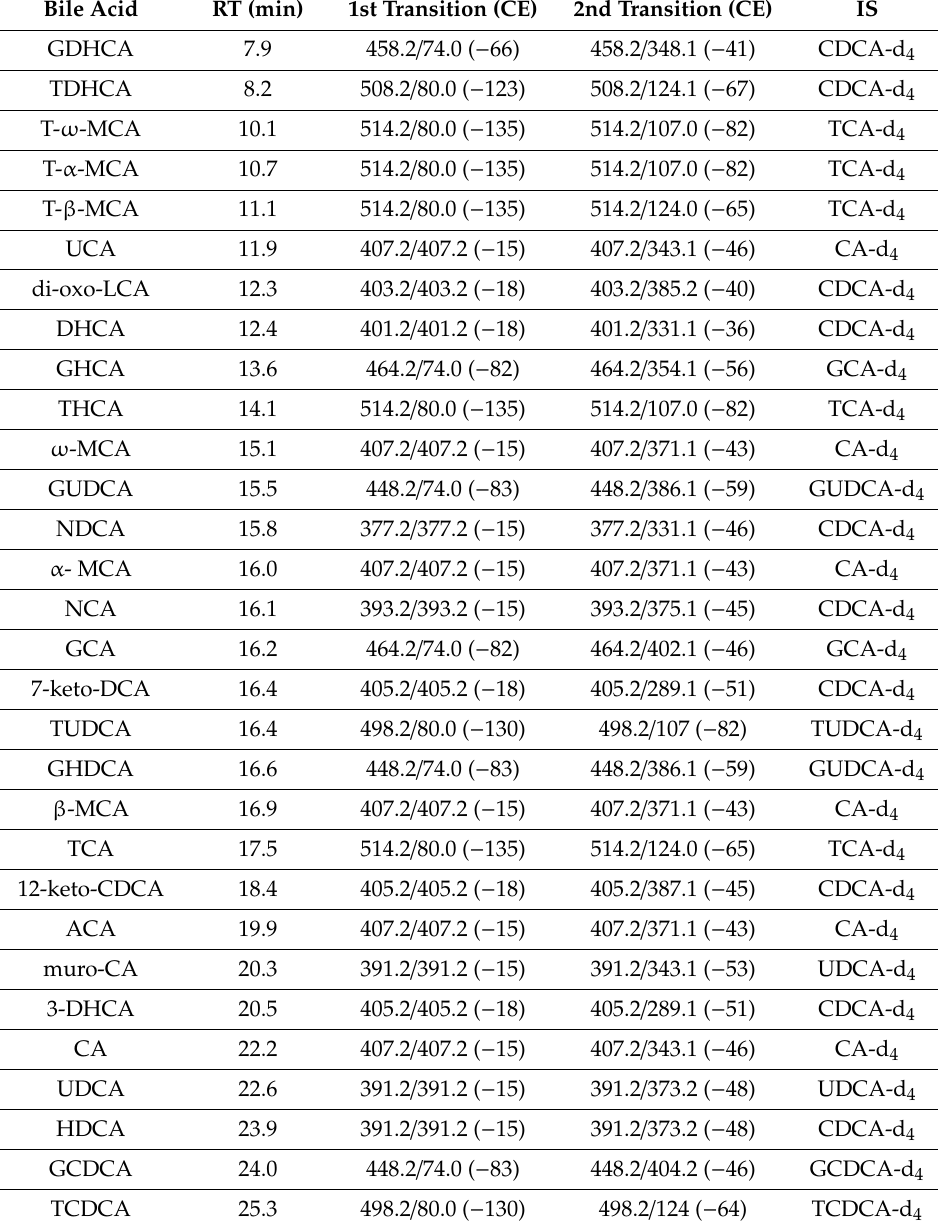
Table 1. Optimized MRM transitions and collision energies for 46 standard bile acids along with their respective retention